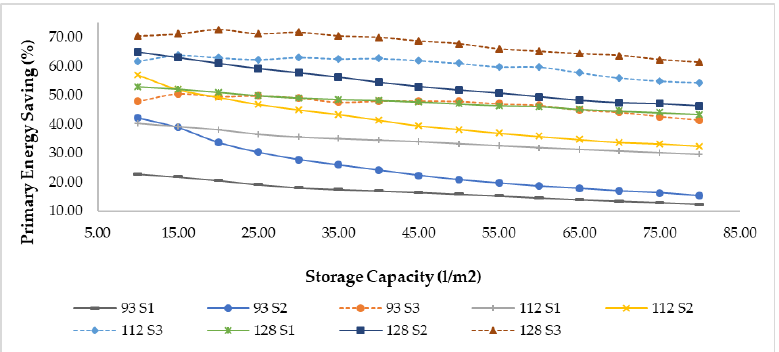
Figure 9. The trend of storage sizes for evacuated tube collector (ETC) areas of 50% PES for all flow schemes.